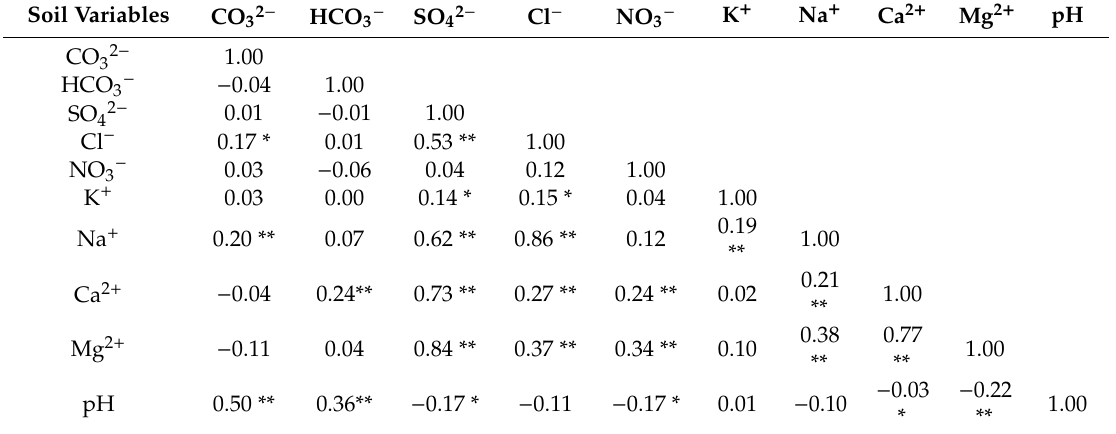
Table 2. Bivariate Pearson correlation coe ffi cients ( r ) for soil chemical variables.